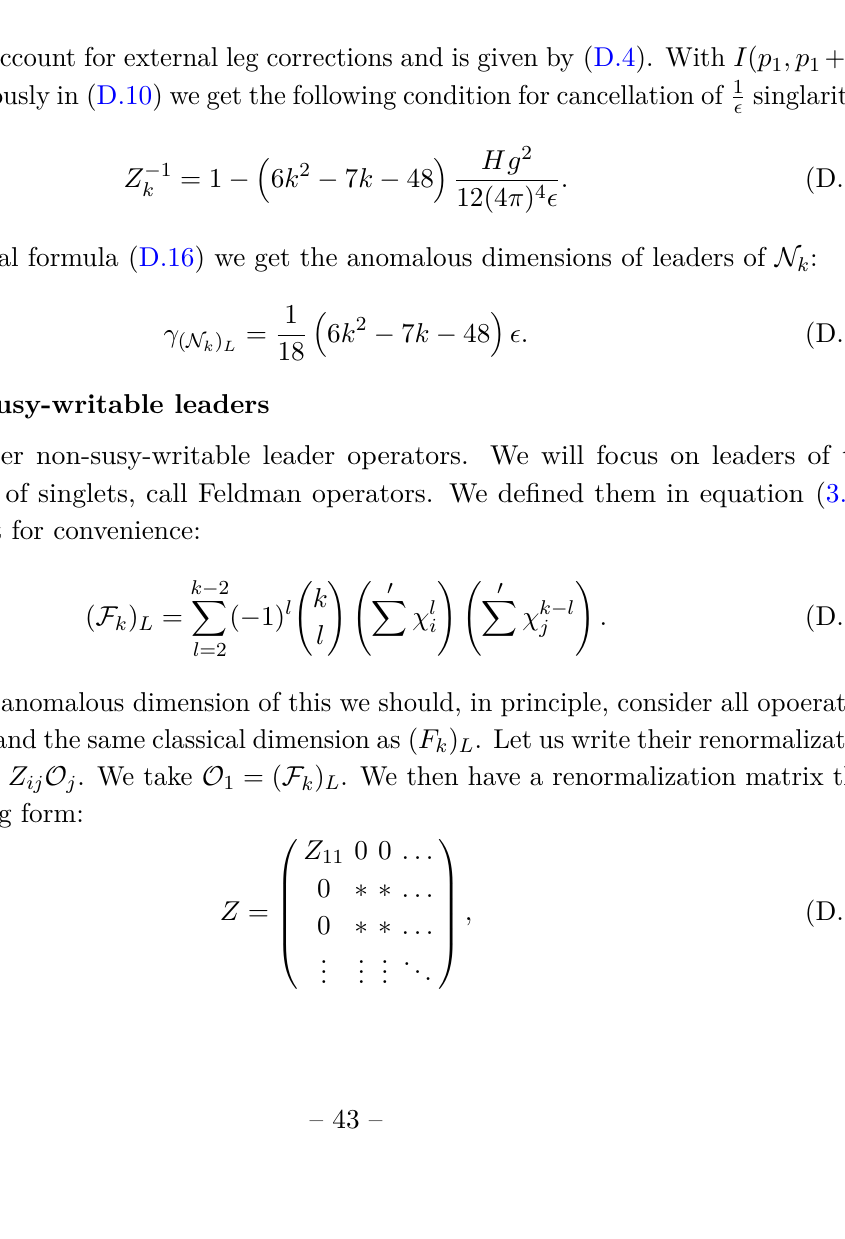
Figure 9 . Diagrams that contribute to the one-loop correction of ( N k ) L